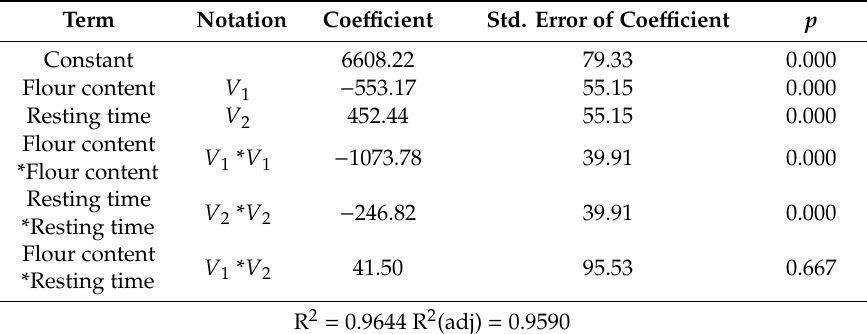
Table 8. Stickiness value for di ff erent flour content and dough resting